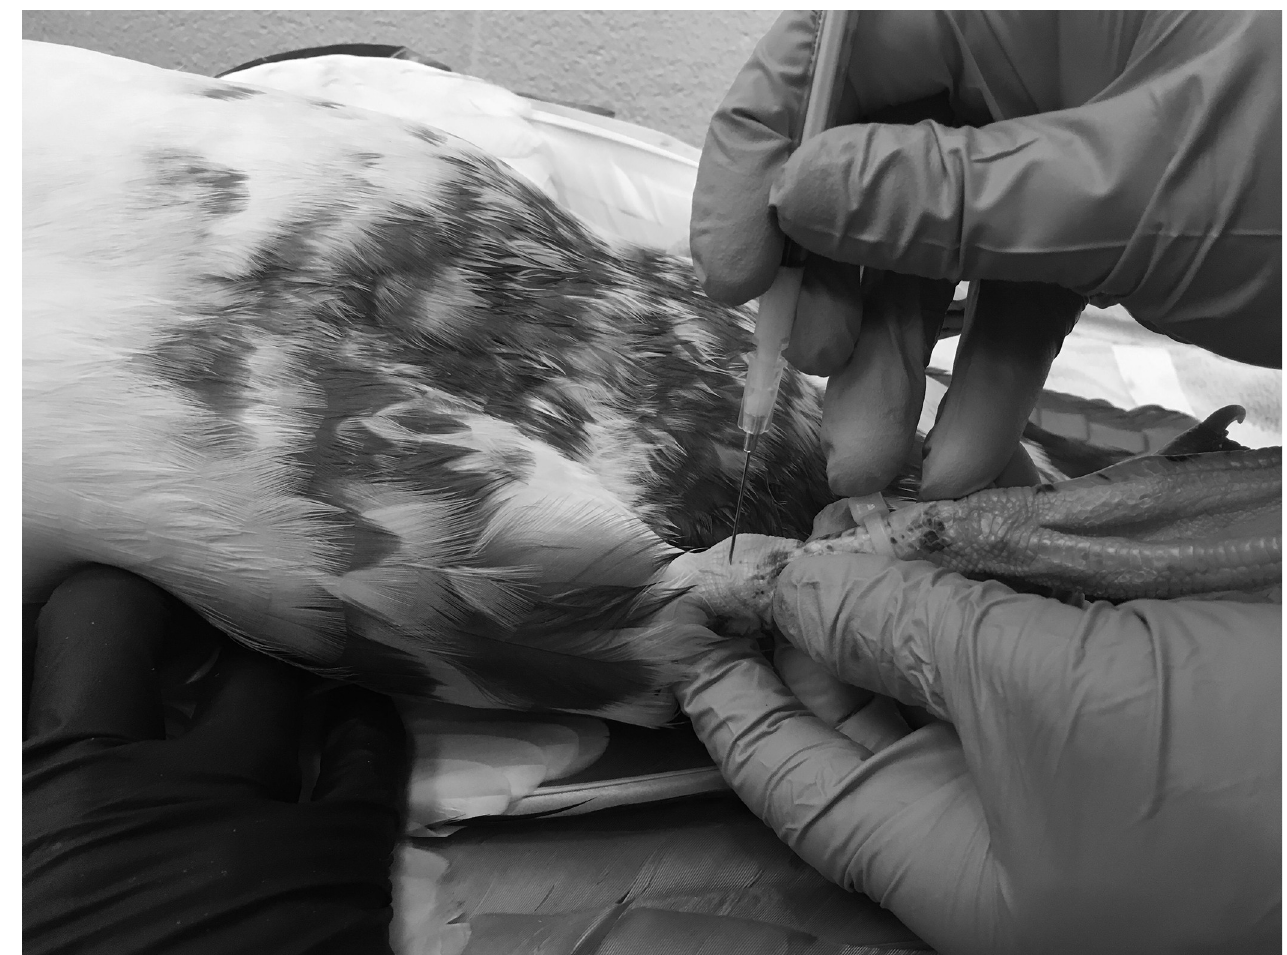
Fig 2. Arthritis induction. Intratarsal injection of monosodium urate solution in an anesthetized Muscovy duck ( Cairina moschata domestica) .